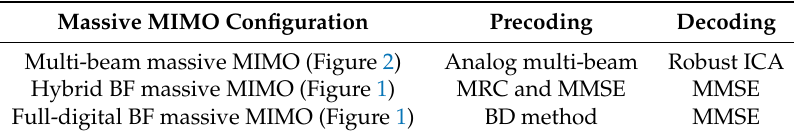
Table 4. Precoding and decoding on